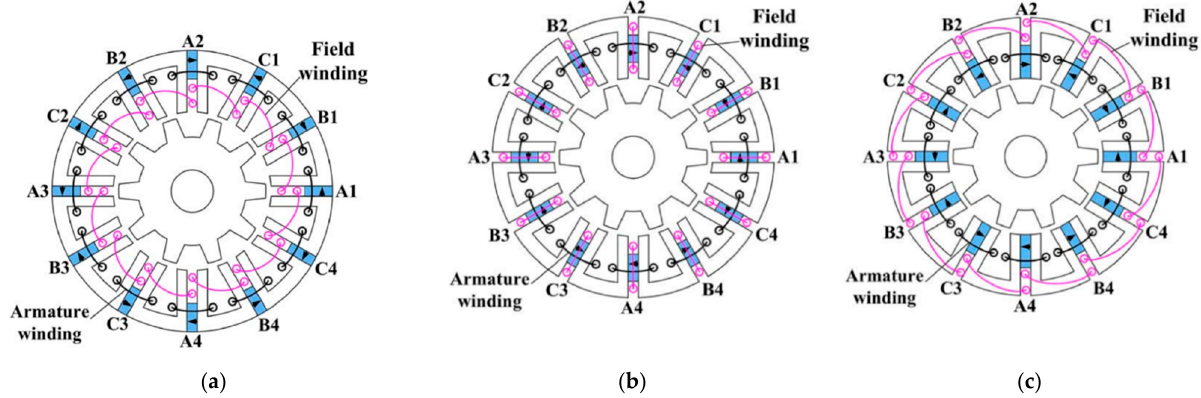
Figure 13. Hybrid-excited FSPM machines: ( a ) PM-bottom; ( b ) PM-top; ( c ) PM-middle [34].